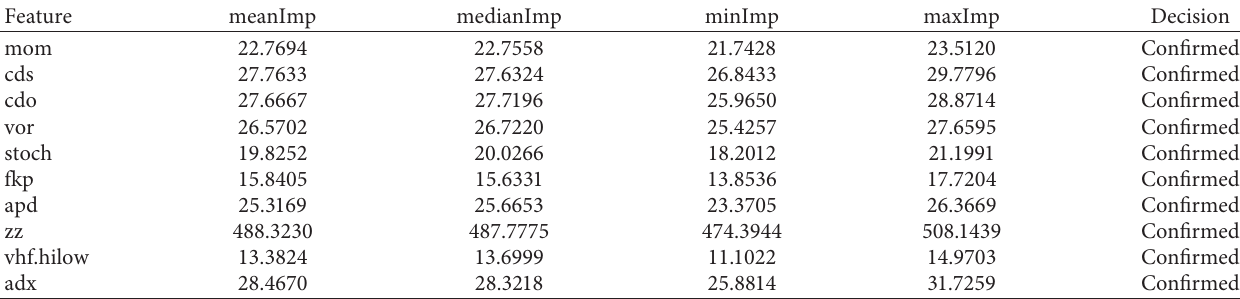
Table 6: Feature statistics.